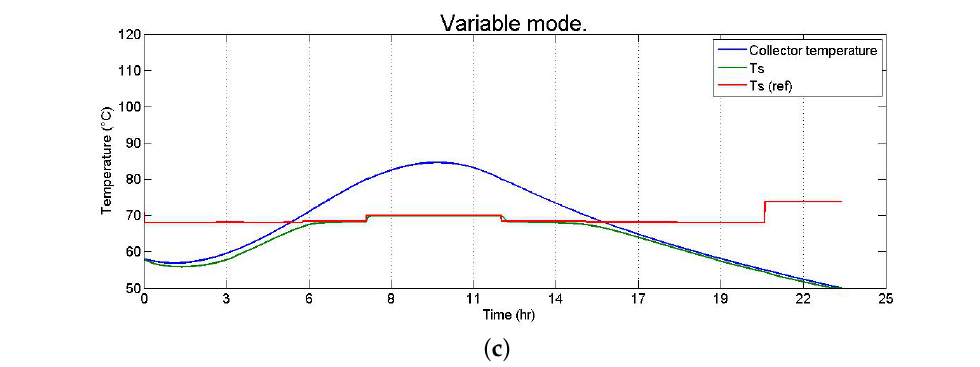
Figure 19. Analysis for different modes of operation with a solar radiation of 500 kW/m 2 , which is considered low radiation. ( a ) Test for Mode 0; ( b ) Mode 5; ( c ) variable mode.